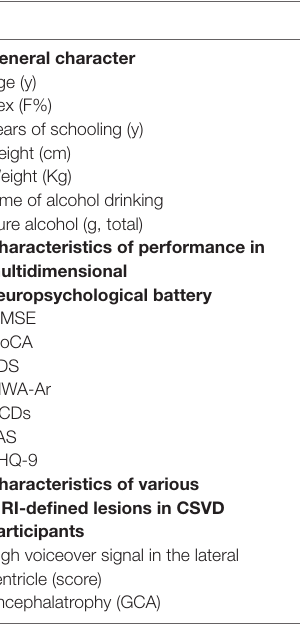
TABLE 1 | Patient demographics and clinical characteristics.